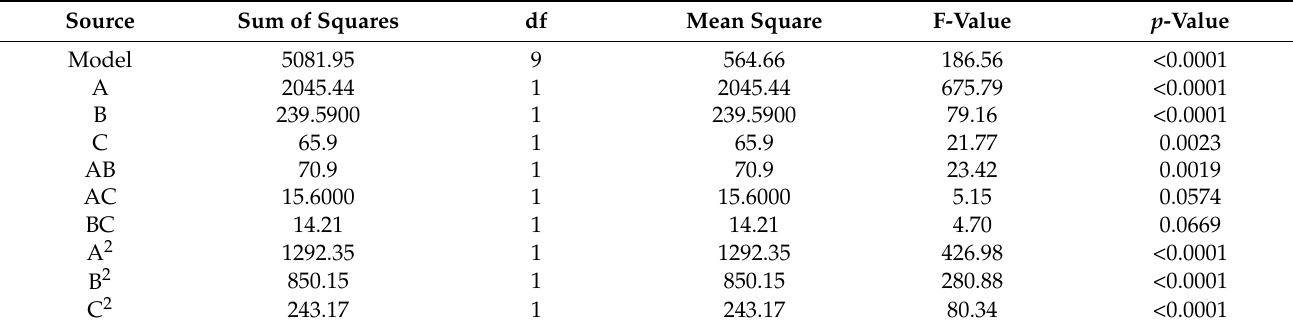
Table 8. Variance results of the quadratic model for the wear resistance.